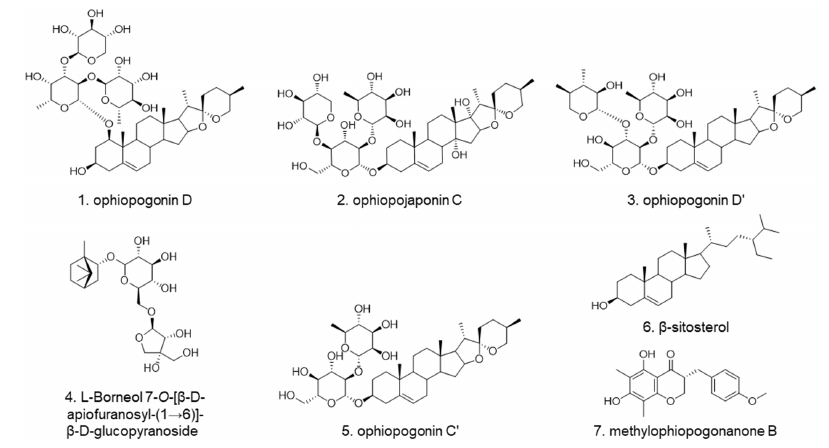
Figure 1. Chemical structures of seven investigated compounds.